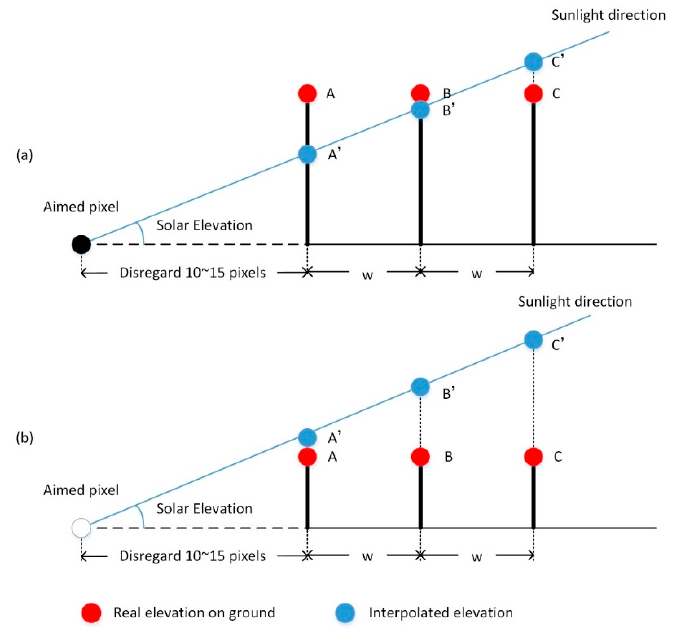
Figure 2. The process of geometric shadow detection: ( a ) judging the target pixel as shadow (black point); and ( b ) judging the target pixel as non-shadow (white point).